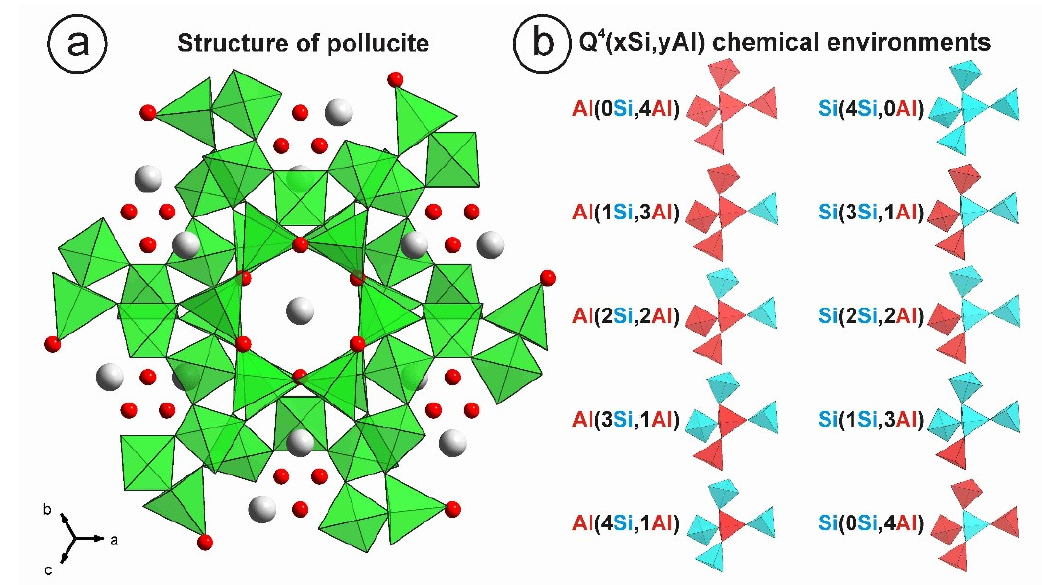
Figure 1. Lattice model of pollucite (Cs,Na)AlSi 2 O 6 showing the structure along the [111] axis and the possible chemical environments for Si and Al atoms. ( a ) At the left side the cubic I a-3d model with the single tetrahedral T site in green is occupied by both Si and Al atoms, showing the different site positions of Cs atoms (gray) and Na atoms (red), according to [8]. ( b ) At the right side the ten possible chemical environments for the single T site, including Si atoms (blue) in Q 4n (4-nSi,nAl) for n = 0, 1, 2, 3 and 4, and Al atoms (red) in q 4 (4-nSi,nAl) for n = 0, 1, 2, 3 and 4.